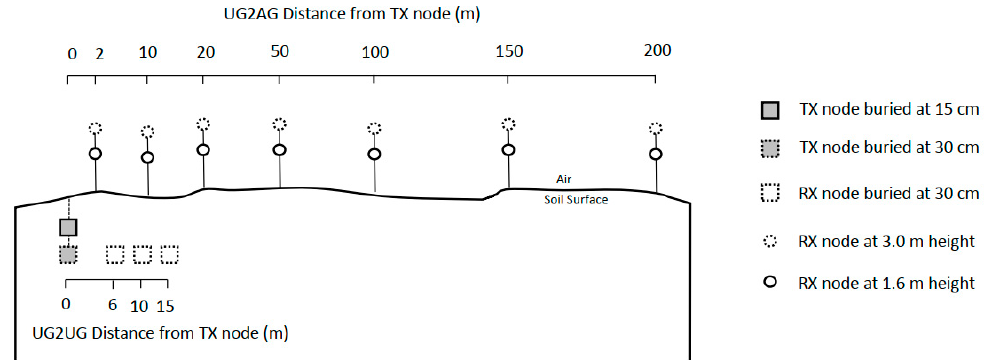
Figure 3. Schematic of field trial layout. Note distance between the TX and receiver (RX) nodes for both UG2AG and UG2UG experiments varied between sites. RX measurement at 3.0 m was only conducted at Site 2.